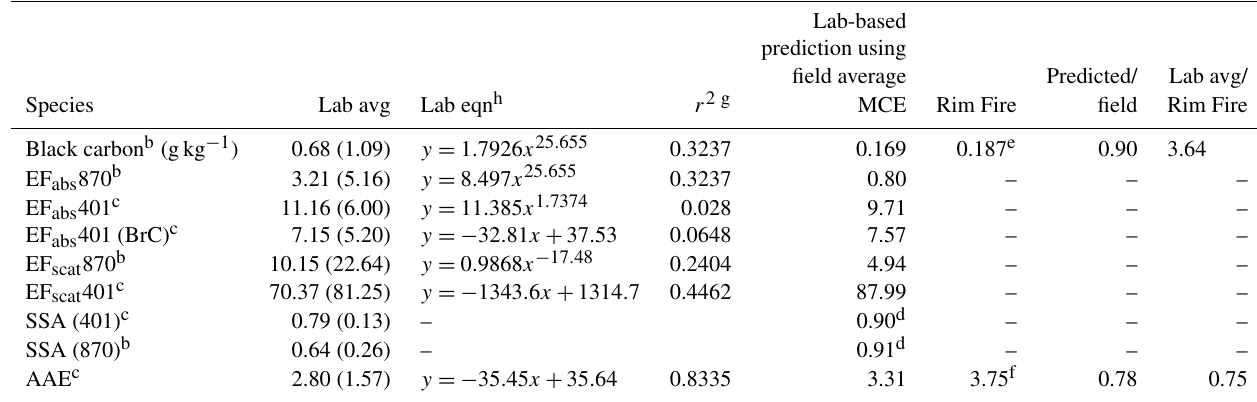
Table 4. Summary of the comparison of optical properties and emission factors (m 2 kg − 1 ) measured in lab to the Rim